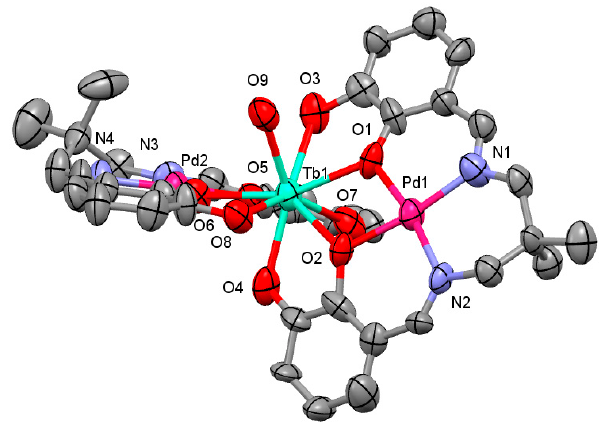
Figure 2. Molecular structure of the coordination unit in 2 .